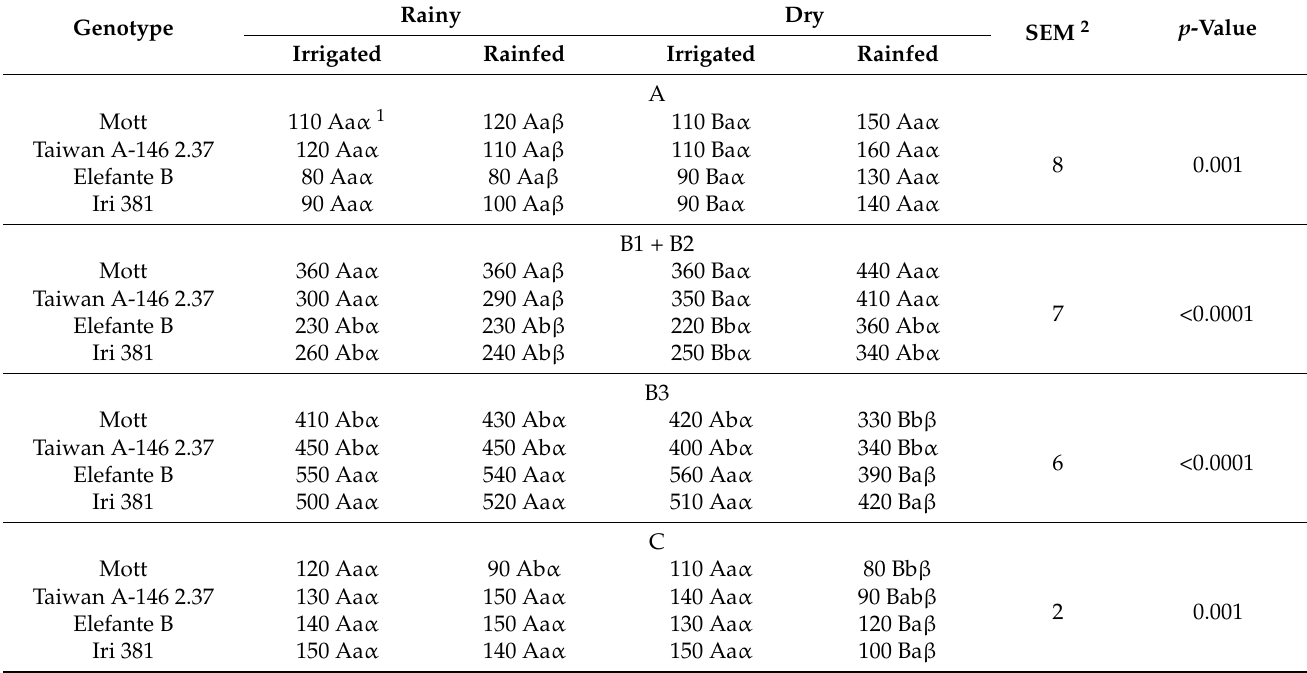
Table 10. Stem protein fractionations (g/kg crude protein) as affected by the interaction between irrigation, genotype, and season for elephantgrass genotypes at Garanhuns, Pernambuco,